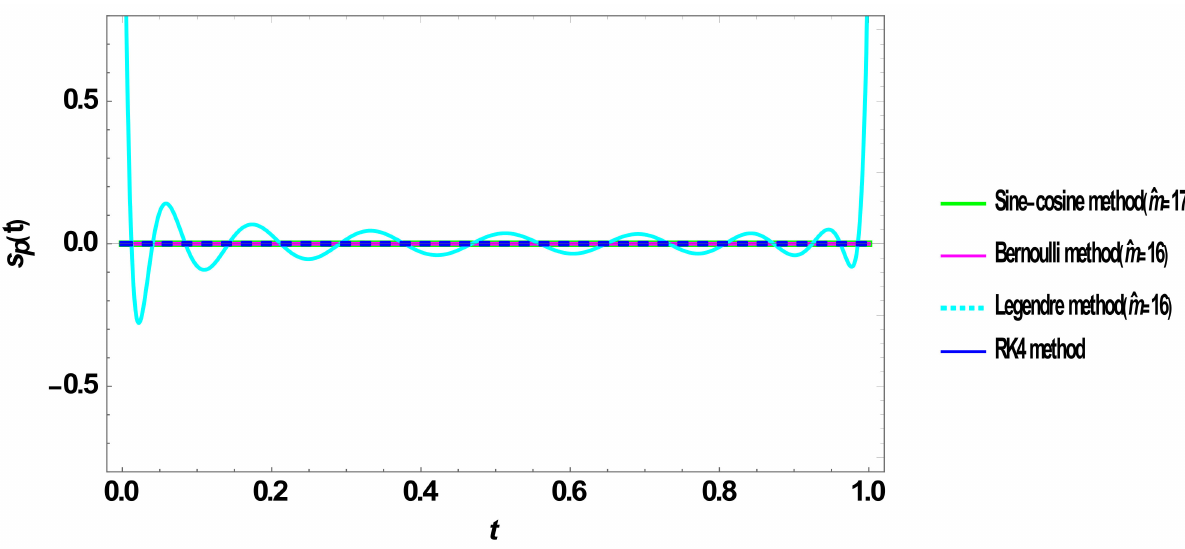
Figure 1. Comparison of the numerical solutions of S p ( t ) by using the sine–cosine wavelets method, Bernoulli wavelets method, ALPs and RK4 methods for υ =